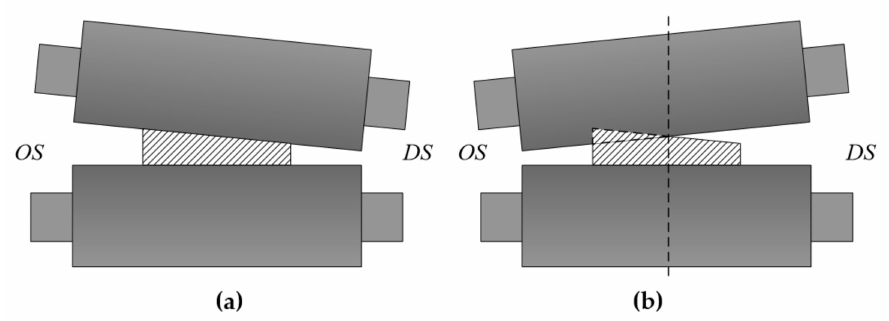
Figure 7. Wedge-shaped feed exiting the rolls ( a ) and ‘reverse’ misalignment of the gap upon entering the rolls ( b